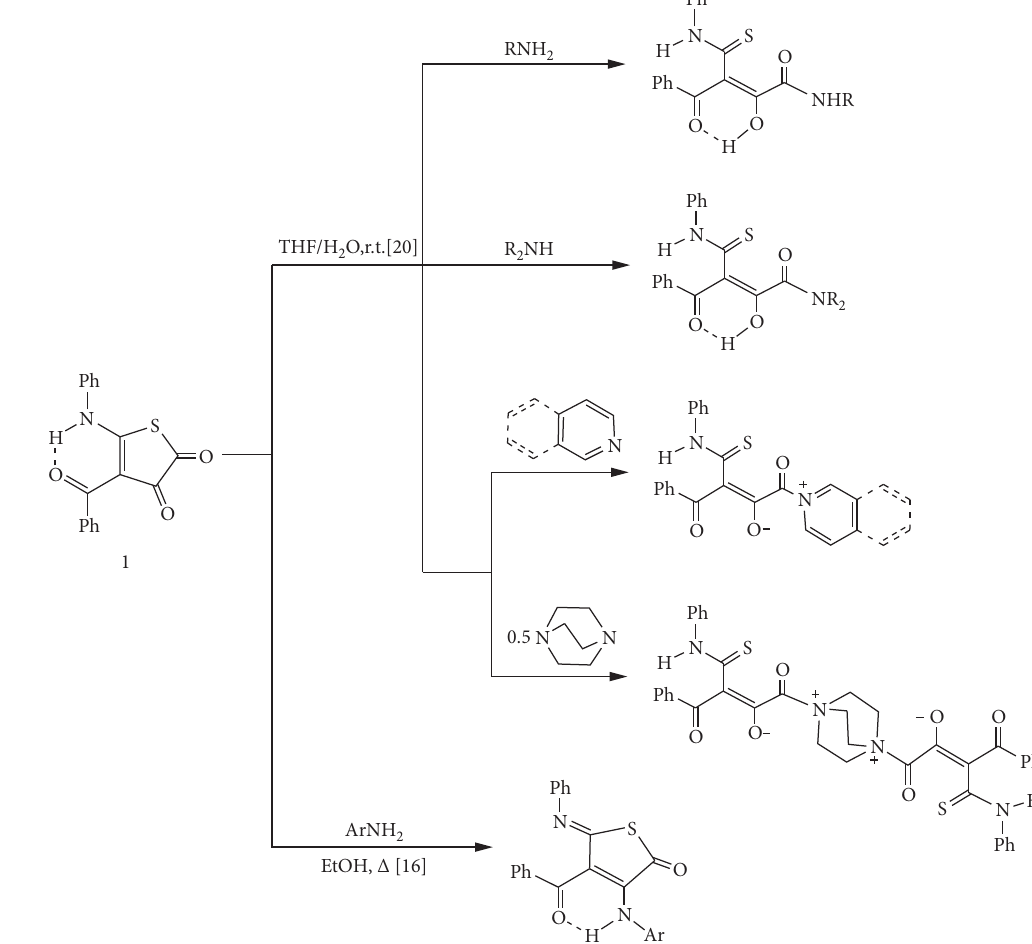
Scheme 1: Earlier works of reactions of 1 with N